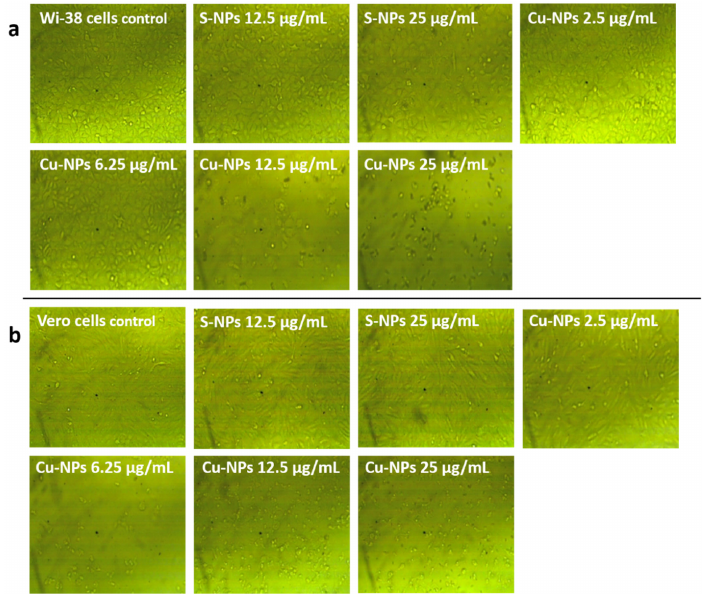
Figure 5. Effects of S-NPs and Cu-NPs at different concentrations on ( a ) WI-38 cells and ( b ) Vero cell viability.